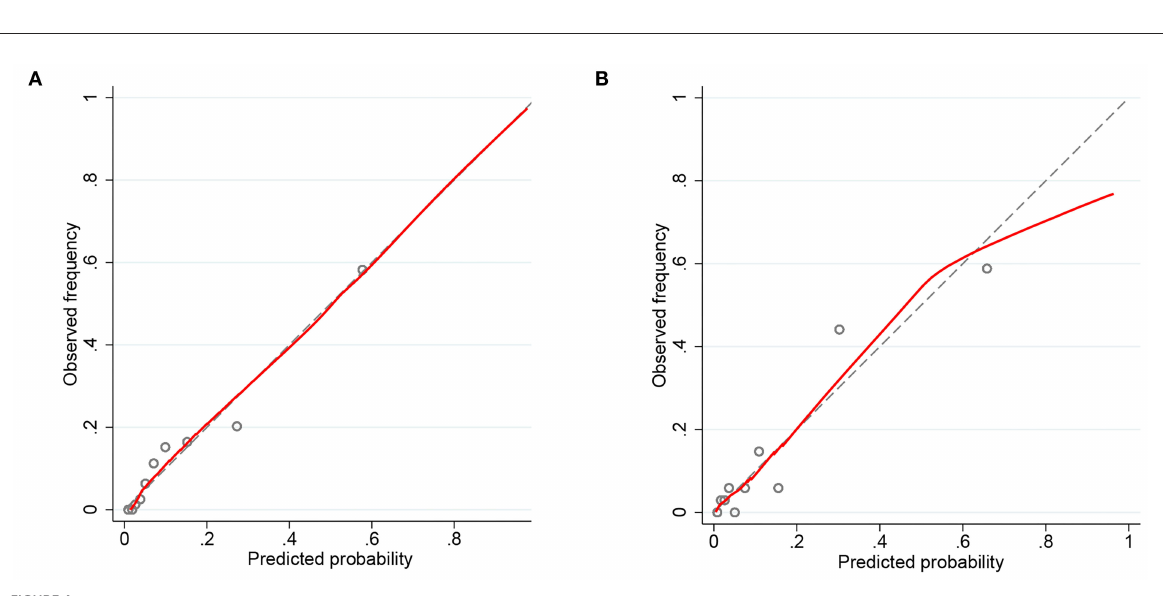
FIGURE4 Calibration curves of the predicted nomogram in the training set (A) and validation set (B) . The x-axis represents the predicted probability calculated by the nomogram, and the y-axis is the observed actual probability of acute kidney injury (AKI). Results of the Hosmer-Lemeshow test demonstrate that the p -value of the training set is 0.8814 and the validation set is 0.4835,